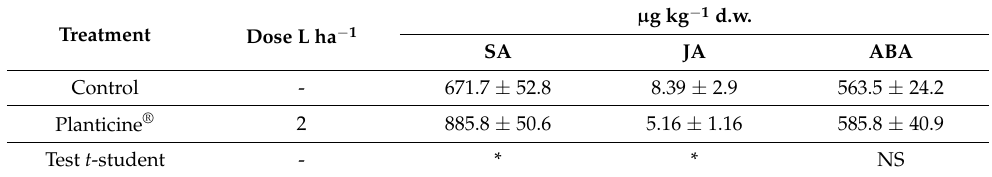
Table 2. Content of salicylic acid (SA), jasmonic acid (JA), and abscisic acid (ABA) in tomato leaves.